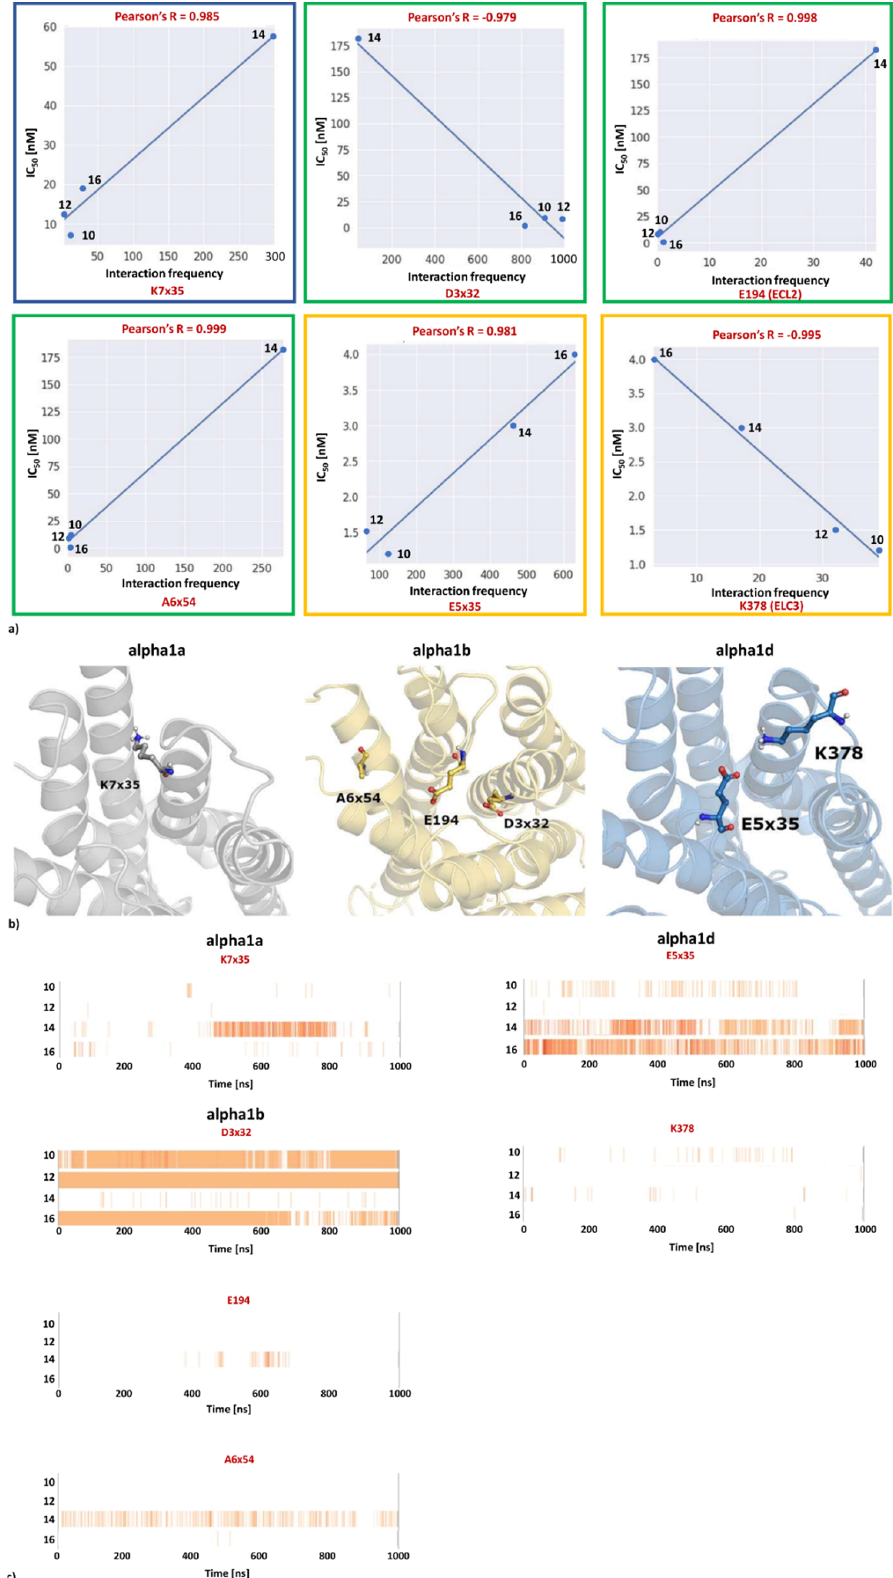
Figure 6. Results of correlation studies ( a ) correlation charts, blue— α 1A R, green— α 1B R, yellow— α 1D R, ( b ) visualization of the most correlated residues, ( c ) contacts of ligands with the most correlated residues which occurred during MD simulation.